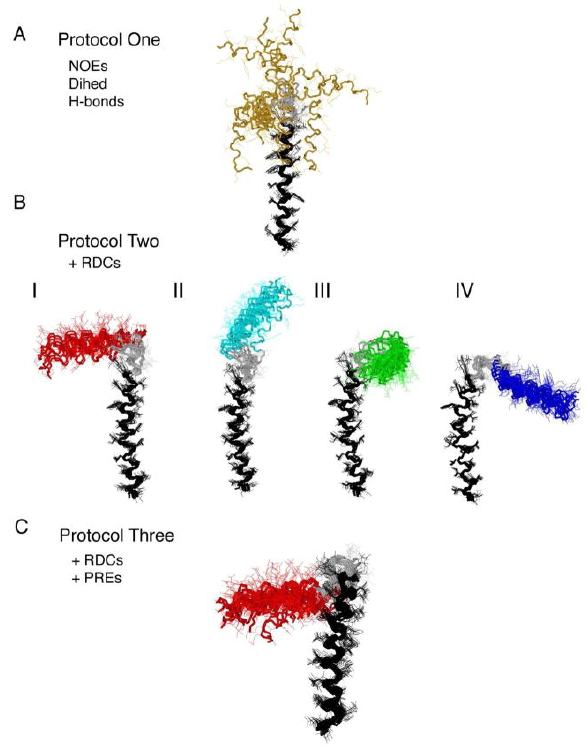
Figure 3. Structures of monomeric phospholamban obtained using ( a ) NOEs, dihedral angle restraints and hydrogen bonds, ( b ) all of the above plus residual dipolar couplings and ( c ) all of the above and PREs. Reproduced with permission from